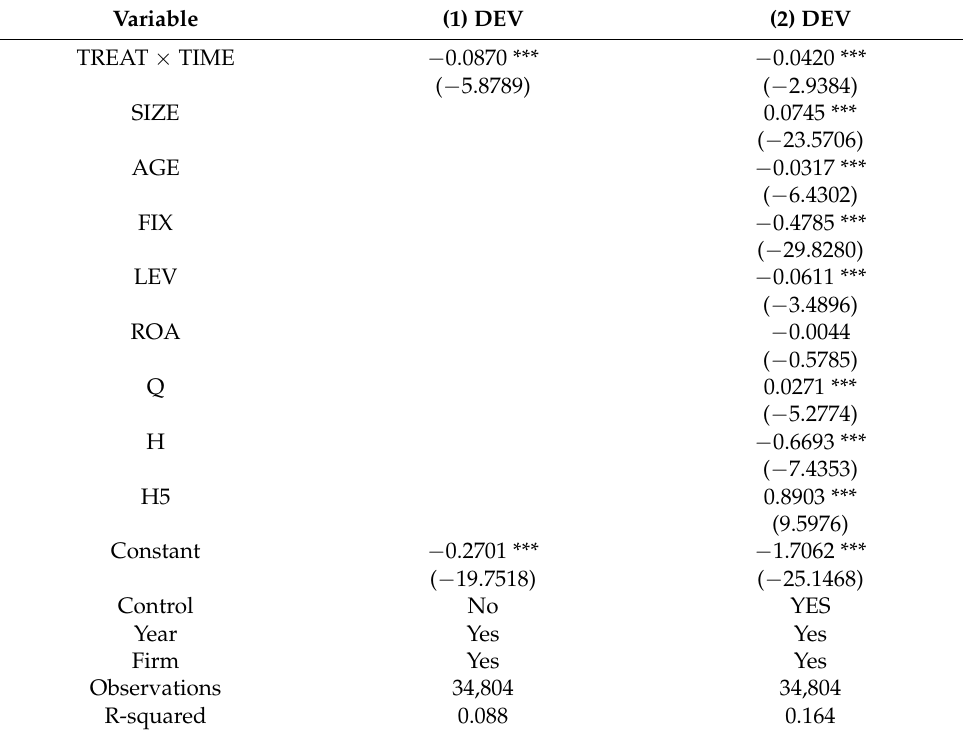
Table 7. Difference-in-differences estimation